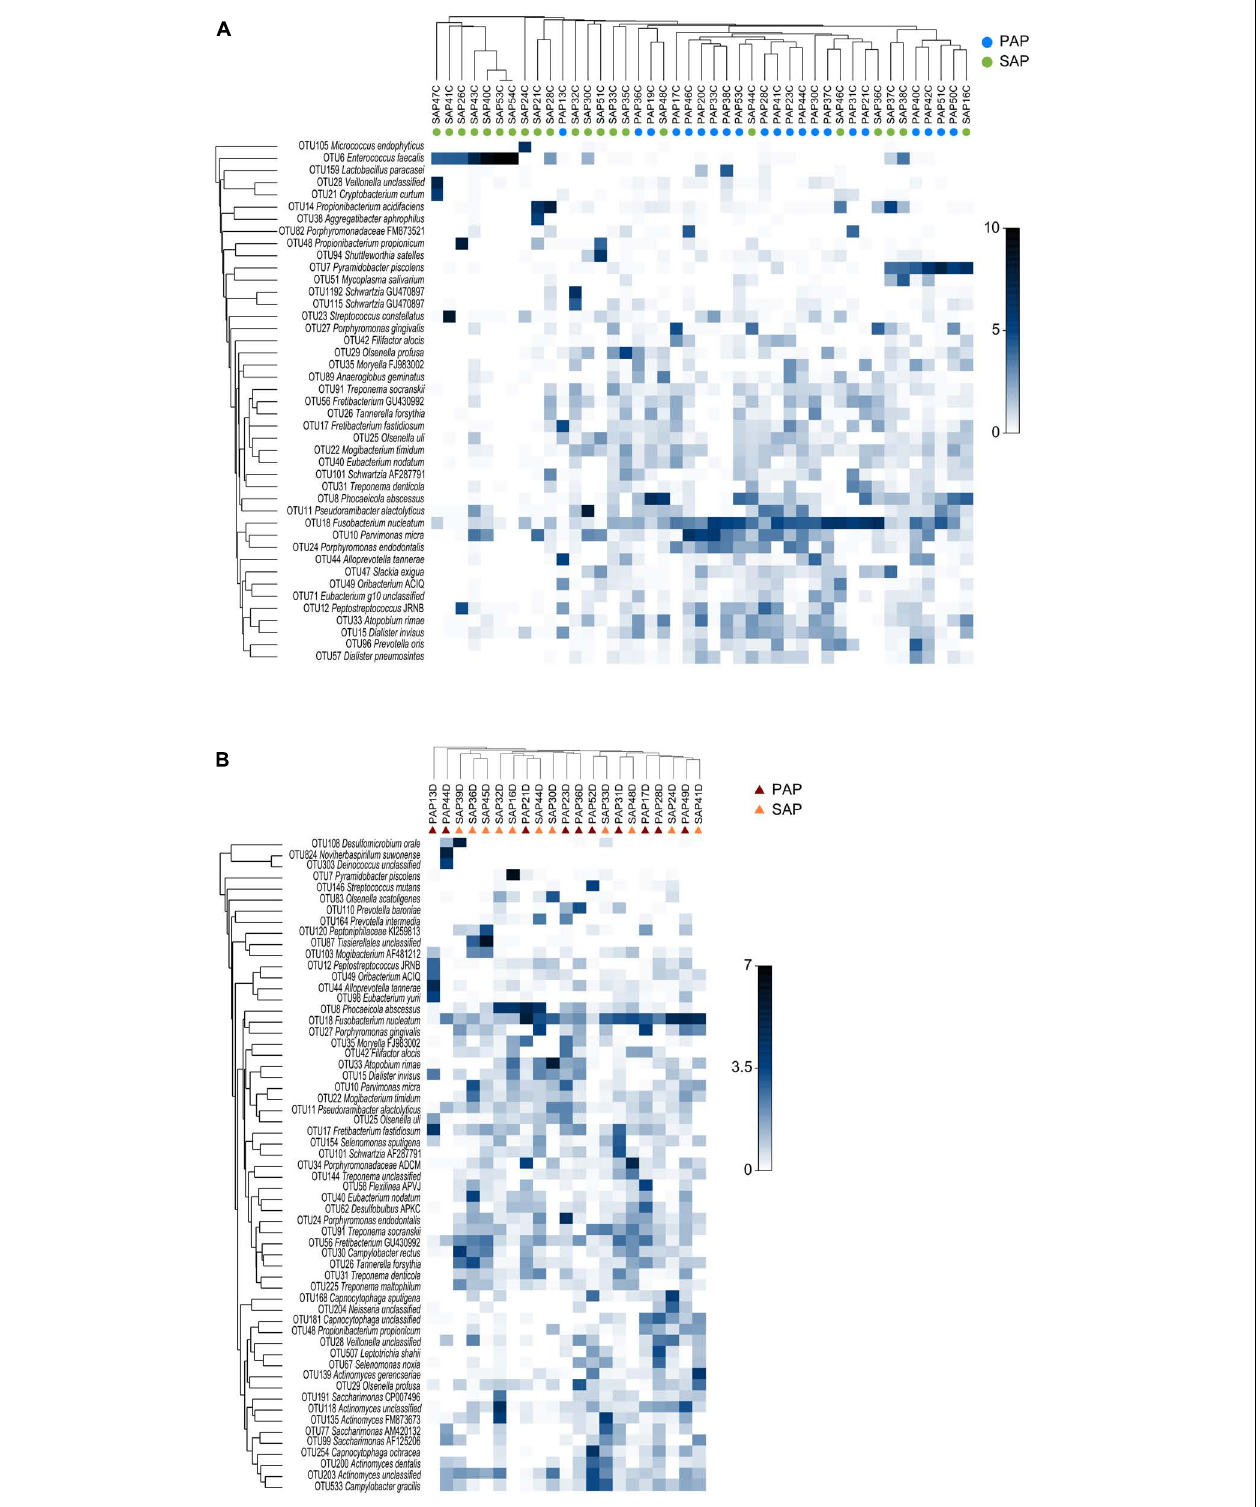
FIGURE 1 | Taxonomic composition and group average clustering of bacterial communities in root canal (A) and dentin (B) . The heat map shows the relative abundance of OTUs across samples. OTUs with average relative abundance > 0.5% in a given sample type are presented. The hierarchical clustering was based on square root-transformed proportions of OTUs and Bray–Curtis similarity matrix. PAP, primary apical periodontitis; SAP, secondary apical periodontitis.